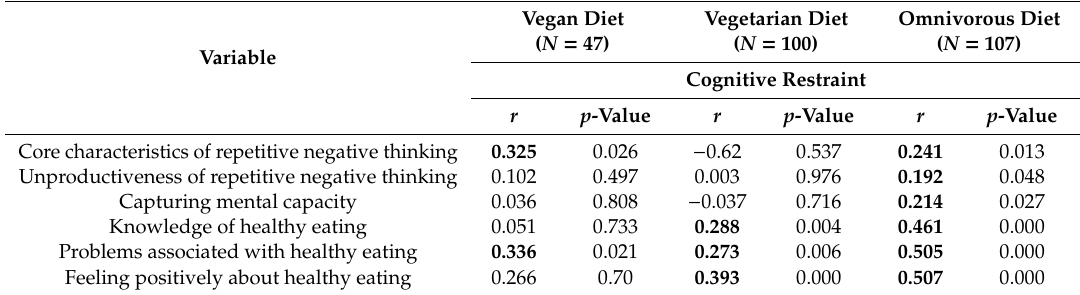
Table 5. Relationships among variables across the dietary patterns.